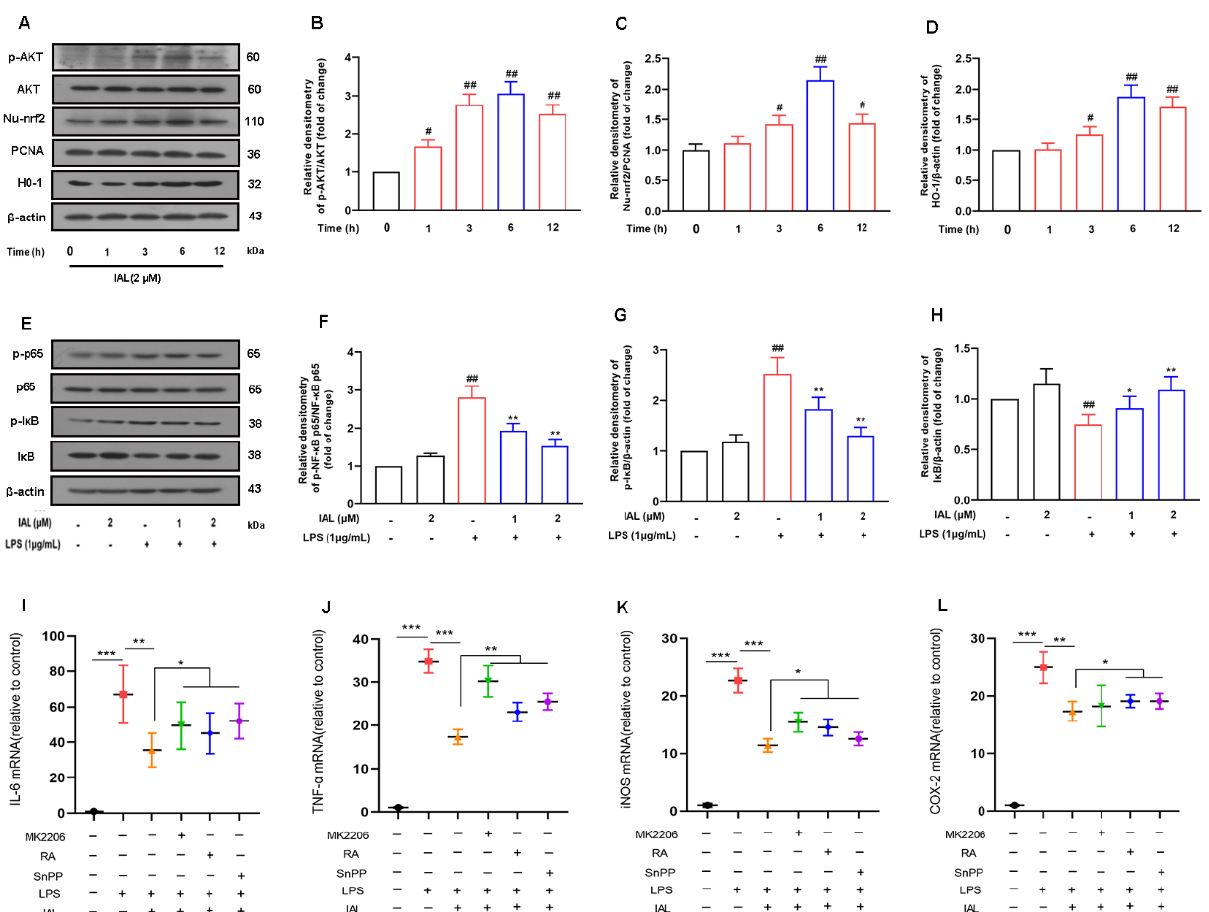
Figure 7. IAL treatment inhibits microglial inflammation by activating the AKT/Nrf2/HO-1 signaling pathway and inhibiting the NF- κ B signaling pathway. ( A – D ) The effect of IAL on the AKT/Nrf2/HO- 1 pathway in BV2 cells was examined with the Western blot method. ( E – H ) The effect of IAL on the NF- κ B pathway in LPS-exposed BV2 cells was examined with the Western blot method. ( I – L ) After pretreatment of cells with MK2206, RA and SnPP, the effect of IAL on the mediators was examined using the real-time PCR method. Results are shown as means ± SEM (n = 3). # p < 0.05, ## p < 0.01, * p < 0.05, ** p < 0.01 and *** p < 0.001 stand for biologically significant differences.